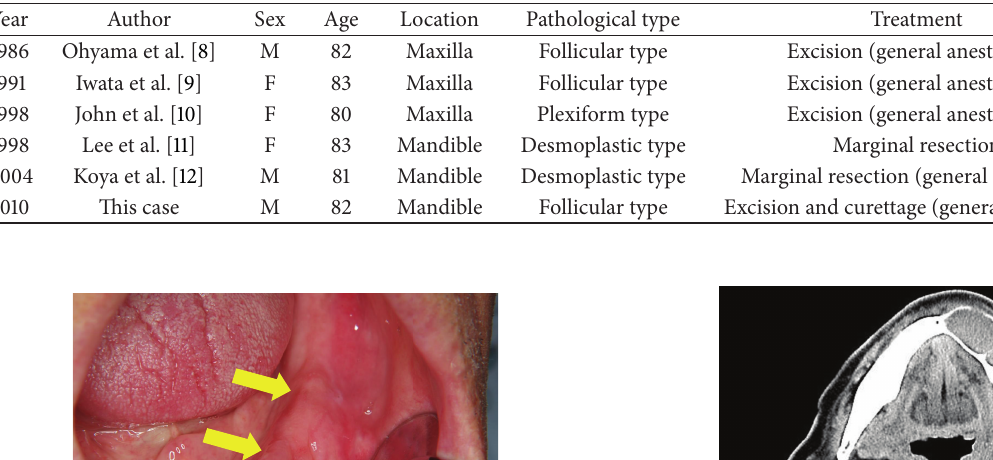
Table 1: Intraosseous ameloblastoma.